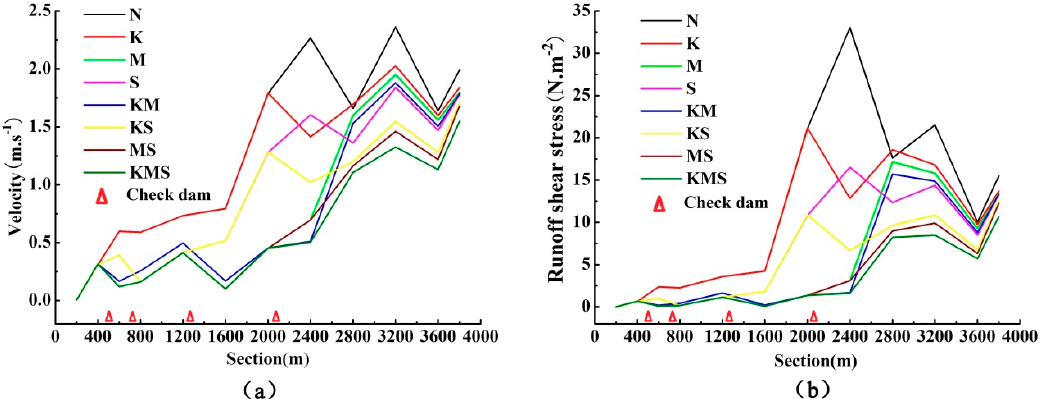
Figure 4. Distribution of erosion dynamic parameters along the channel under different working conditions. Table 4. Erosion dynamic parameters of the exit section of the watershed under different working conditions.